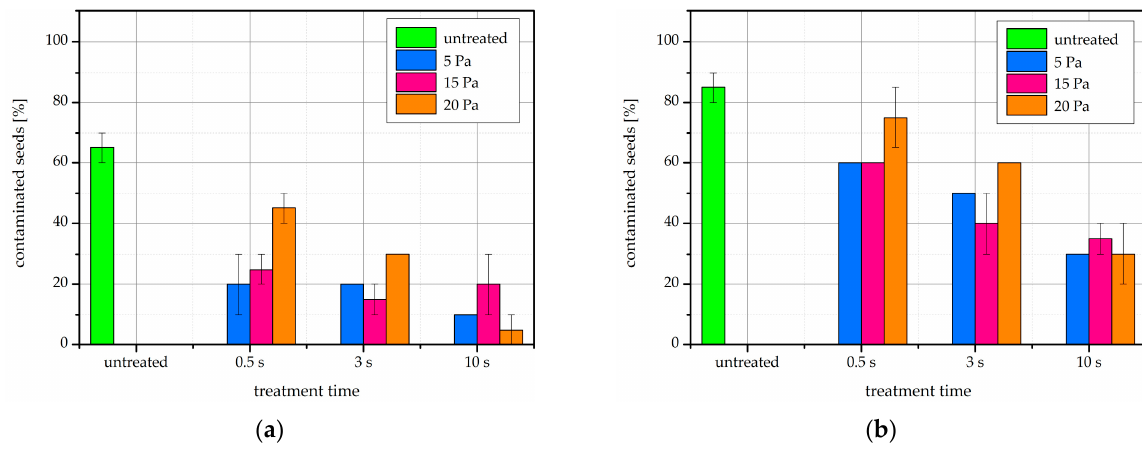
Figure 11. The proportion of bean seeds contaminated with a fungal infection after ( a ) 4 days and ( b ) 7 days of incubation at germination conditions. The error bars represent standard error.